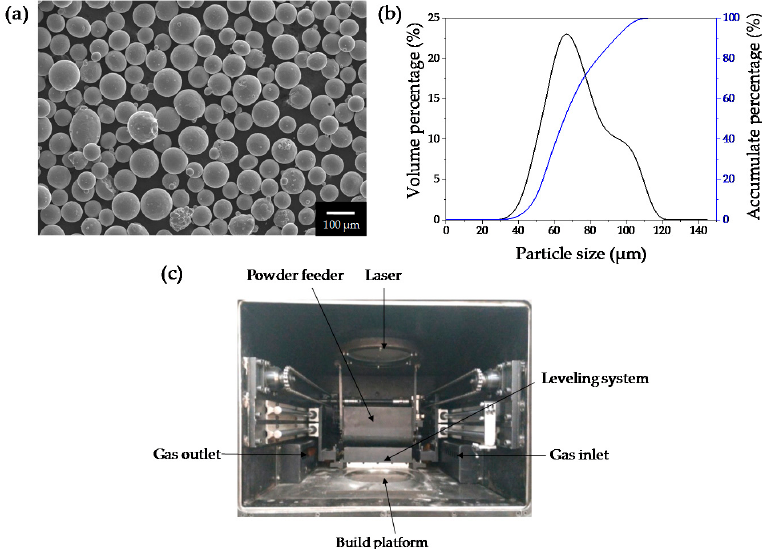
Figure 1. ( a ) Ti6Al4V powder morphology; ( b ) particle size distribution; ( c ) selective laser melting system developed by Beijing Institute of Technology.